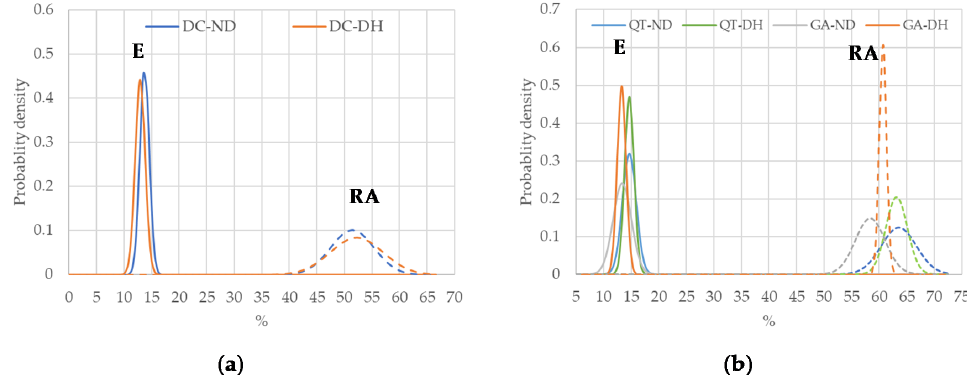
Figure 11. Probability density plot assuming Normal distribution of average elongations and area reduction and their uncertainties in Table 6 as mean and standard deviation values. ( a ) Plot for the DC Class 8.8 specimens. ( b ) Plot for the QT and GA Class 10.9 specimens.